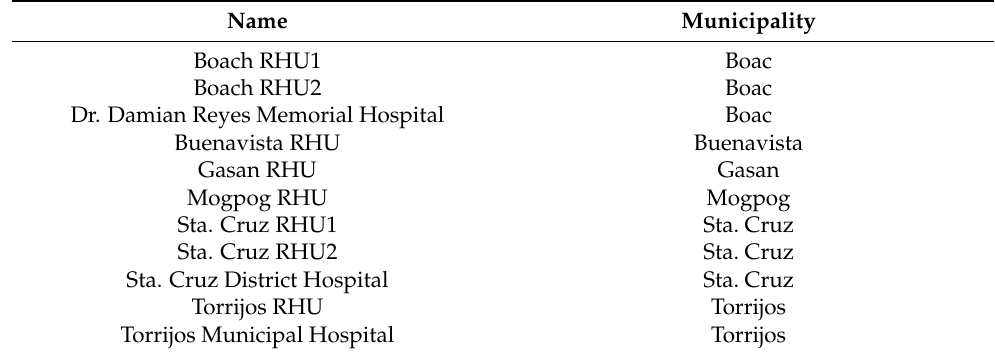
Table 1. Healthcare facilities in Marinduque, Philippines.